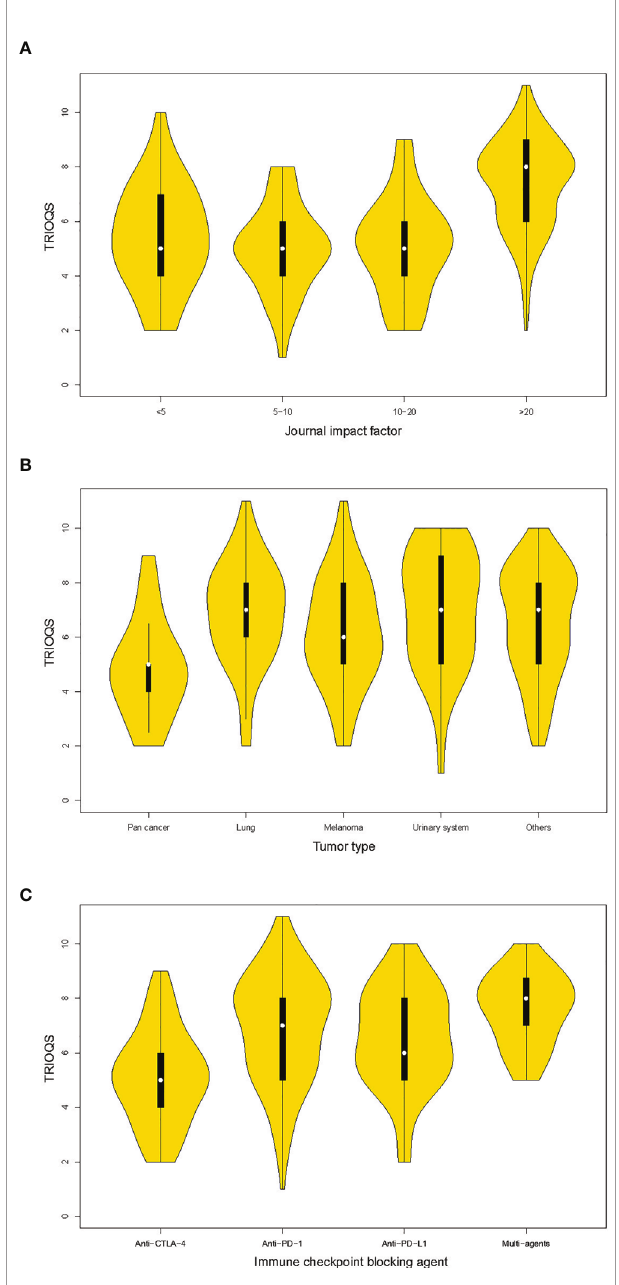
FIGURE 2 | Violin plots of trial reporting of immuno-oncology quality score (TRIOQS) by characteristics of publications. (A) Journal impact factor; (B) tumor type; (C) immune checkpoint blocking agent. The white dot is the median value. The black box ranges from the lower quartile to the upper quartile values, and the thin black line indicates 95% con fi dence interval. The outer shape is the kernel density